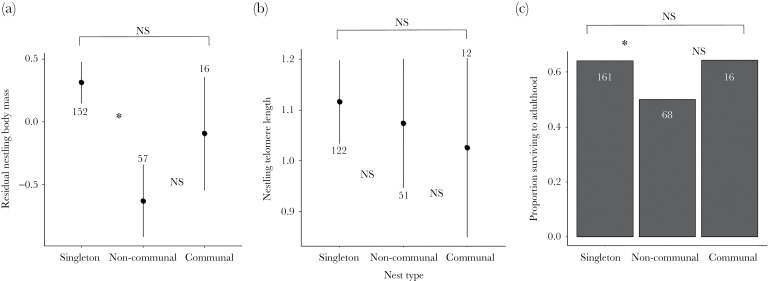
Differences in individual costs of offspring rivalry in terms of (a) residual body mass (controlling for tarsus length, sampling time and date), (b) telomere length, and (c) survival to adulthood, between singleton and either noncommunal or communal broods in the Seychelles warbler. In (a) and (b) dots and lines denote mean and standard error, respectively; in (b) bars represent mean values. In all panels, numbers represent sample size per group. Significant (“*”) and nonsignificant (“NS”) differences between groups at < 0.05 are displayed.